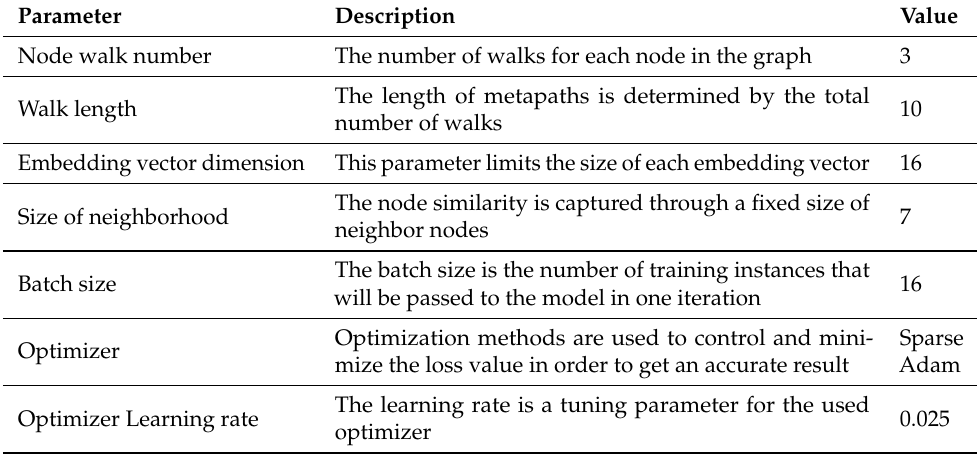
Table 7. Settings and hyper-parameters for metapath2vec